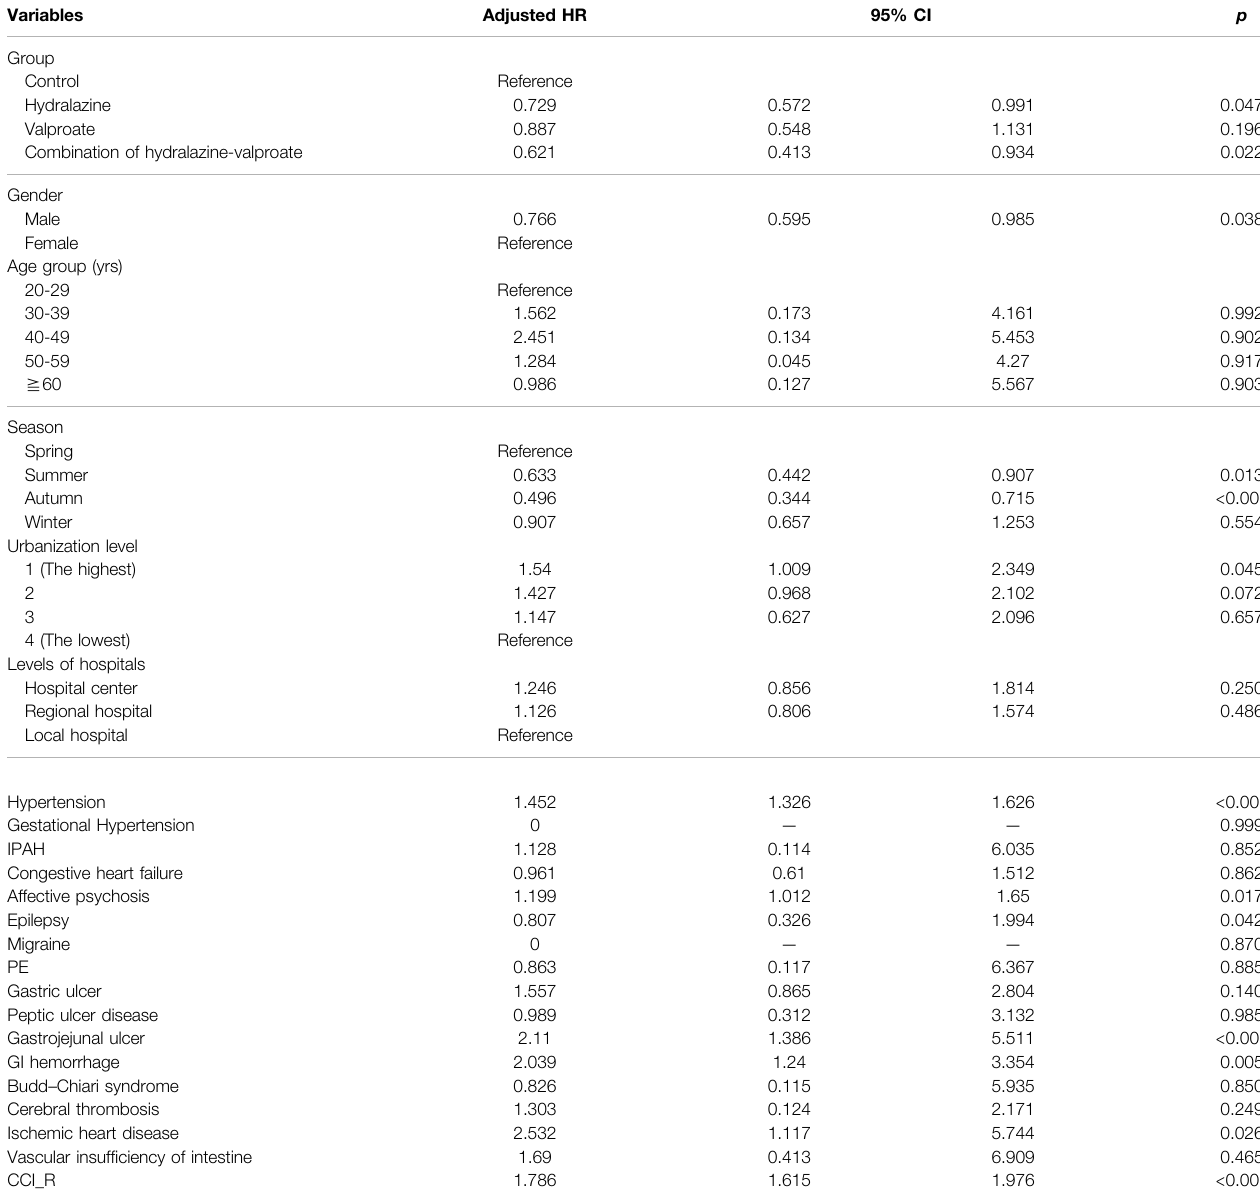
TABLE 1 | Factors affecting risk of requiring therapeutic phlebotomy determined using Cox